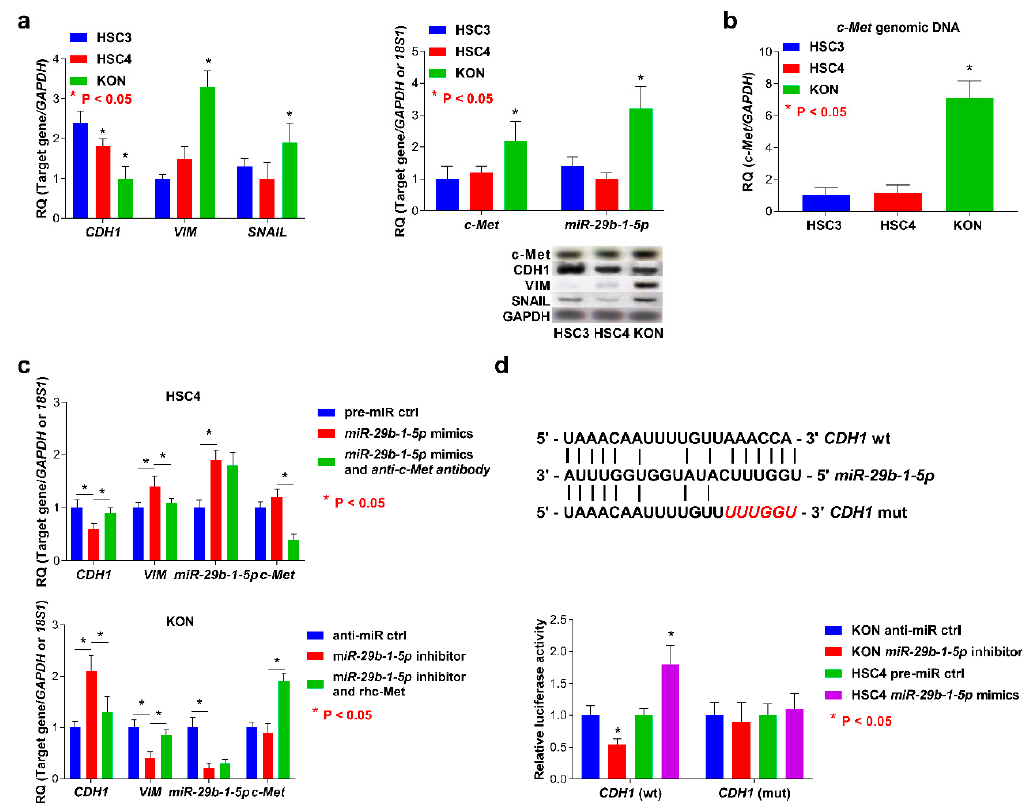
Figure 3. Analysis of the status of the EMT and c-Met and miR-29b-1-5p expression and function of miR-29b-1-5p in OSCC cells. ( a ) The levels of expression of miR-29b-1-5p and c-Met in KON cells were higher than those of HSC3 and HSC4 cells (left). Upregulation or downregulation of CDH1 or SNAI1 and VIM was detected in KON cells, respectively (right). ( b ) MET genomic DNA was amplified compared with the copy numbers measured in HSC3 and HSC4 cells. ( c ) Induction of the EMT was mediated through the interaction of miR-29b-1-5p with c-Met in OSCC cells. ( d ) The 3 ′ -UTR of CDH1 contains miR-29b-1-5p binding sites. Reporter constructs showing wild-type (wt) and mutated (mut) CDH1 3 ′ UTR sequences (top). Luciferase activity of OSCC cells transfected with reporter vectors containing the wt or mut 3 ′ -UTR of CDH1 . Error bar: standard deviation (bottom). RQ: relative quantitation.